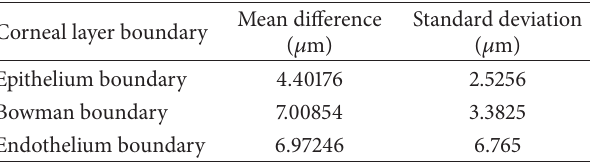
Table 3: Mean and standard deviation of unsigned error in corneal layer boundary segmentation between automatic and manual seg- mentation using level set.